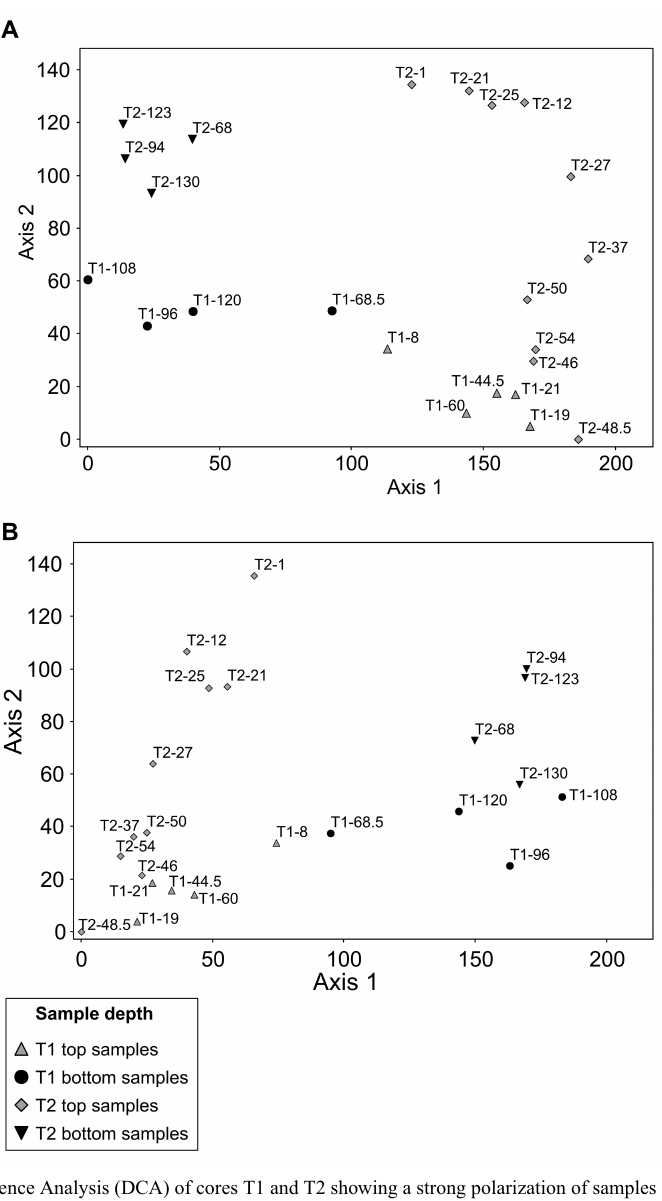
Fig. 2 – Detrended Correspondence Analysis (DCA) of cores T1 and T2 showing a strong polarization of samples along Axis 1. A) DCA carried out on percentage pollen data of all species that were present on both cores together. B) DCA carried out on percentage pollen data of shared species. Various symbols were used to characterize different samples: black circles for bottom samples from T1; gray triangles for top samples of T1; black upside down triangles for bottom samples of T2; and gray diamonds for top samples of